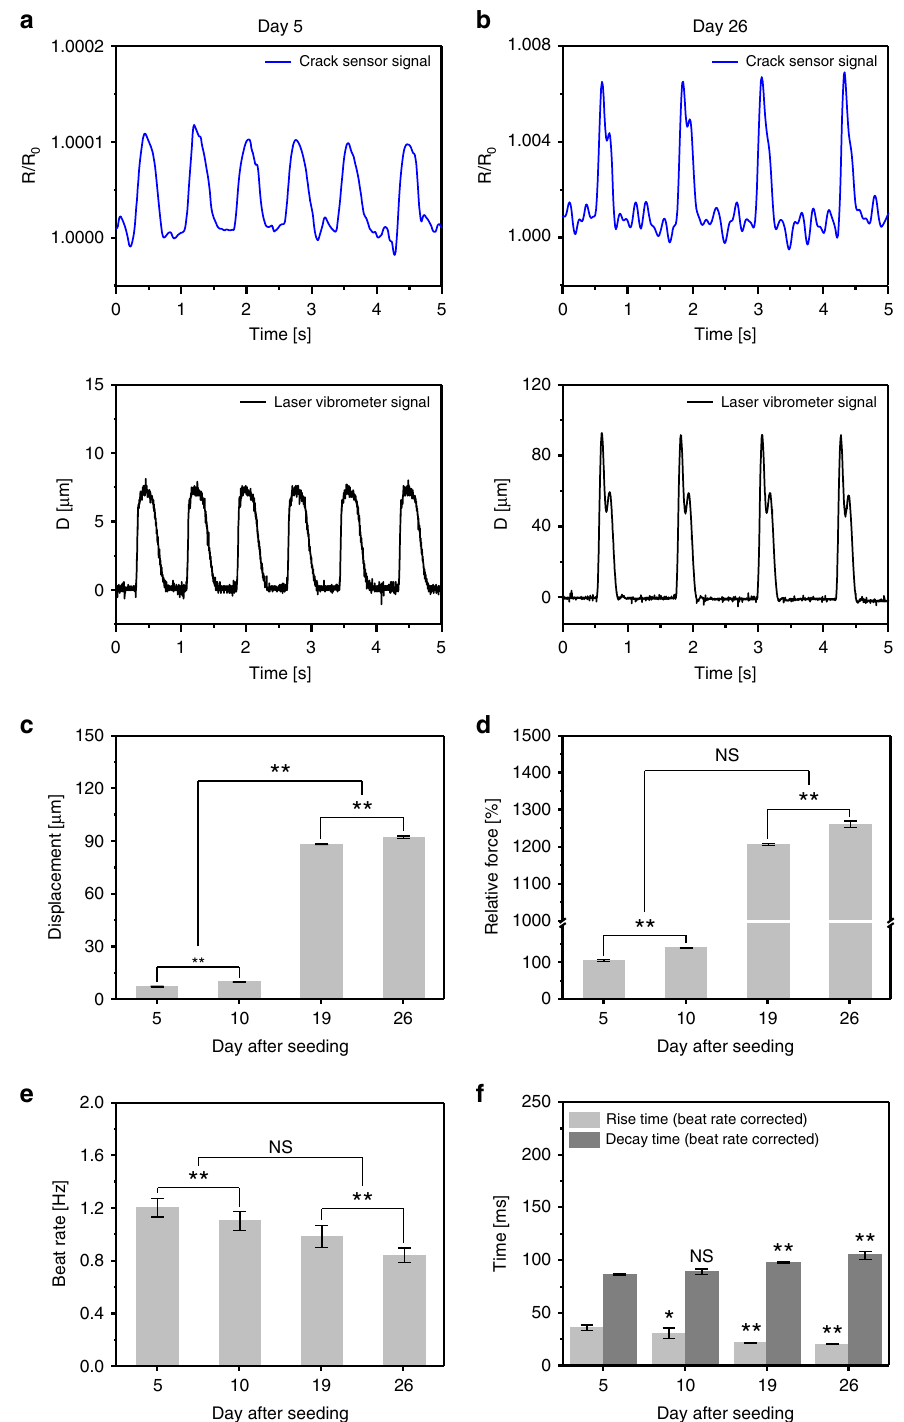
Fig. 4 Long-term stability of the PDMS-encapsulated crack sensor integrated with silicone rubber cantilever. a , b Representative traces of real-time change in resistance ratio and displacement of the cardiomyocytes cultured PDMS-encapsulated crack sensor at day 5 and 26 of the culture days. c Displacement of the cardiomyocytes seeded PDMS-encapsulated crack sensor integrated with silicone rubber cantilever at different culture periods. d , e Relative contraction force, and a beat rate of the cardiomyocytes at different culture periods. f Rise time and decay time of cultured cardiomyocytes measured over 26 days. c – e (** p < 0.01 measures by two-way ANOVA followed by Tukey ’ s honest signi fi cant difference test). The rise time and decay time were analyzed, and beat rate corrected with Fridericia ’ s formula (Rise time corrected (Rc) = R/interspike interval 1/3 ) and (Decay time corrected (Dc) = D/interspike interval 1/3 ), respectively. (* p < 0.05, ** p < 0.01 measures by one-way ANOVA followed by Tukey ’ s honest signi fi cant difference test). Error bars are mean ± s.d. ( n = 5 biologically independent samples). NS and D represent displacement and nonsigni fi cant,